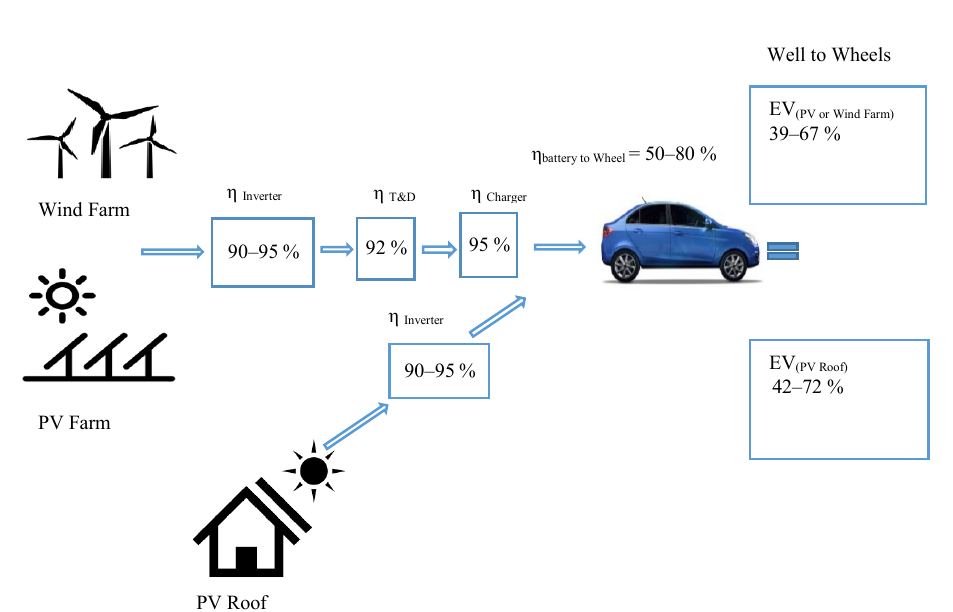
Fig. 5. WTW efficiency of EVs from renewable energy